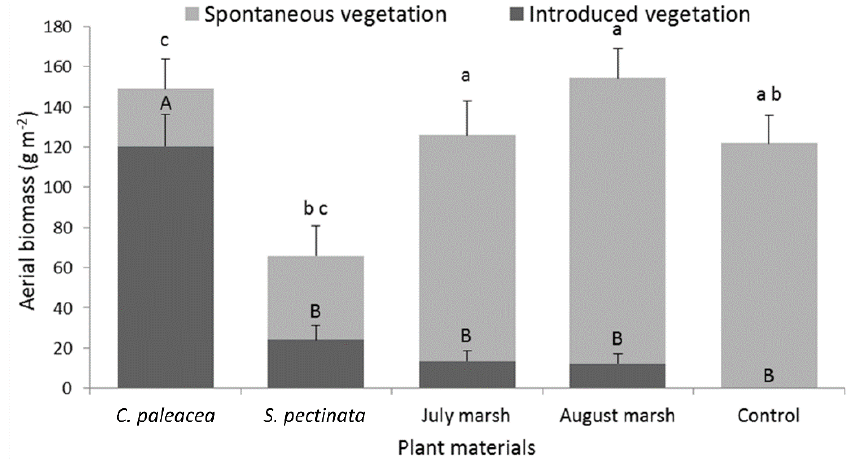
Figure 4. Mean aerial biomass of introduced and spontaneous vegetation according to the type of plant material introduced in the field experiment (pooled data across fertilisation treatment; error bars: ± SE). Different letters indicate significant differences between treatments. Capital letters and lower error bars refer to the introduced vegetation while lowercase letters and upper error bars refer to spontaneous vegetation. See Table A2 for results of the statistical analyses. Note that total biomass (spontaneous + introduced vegetation) did not differ significantly between